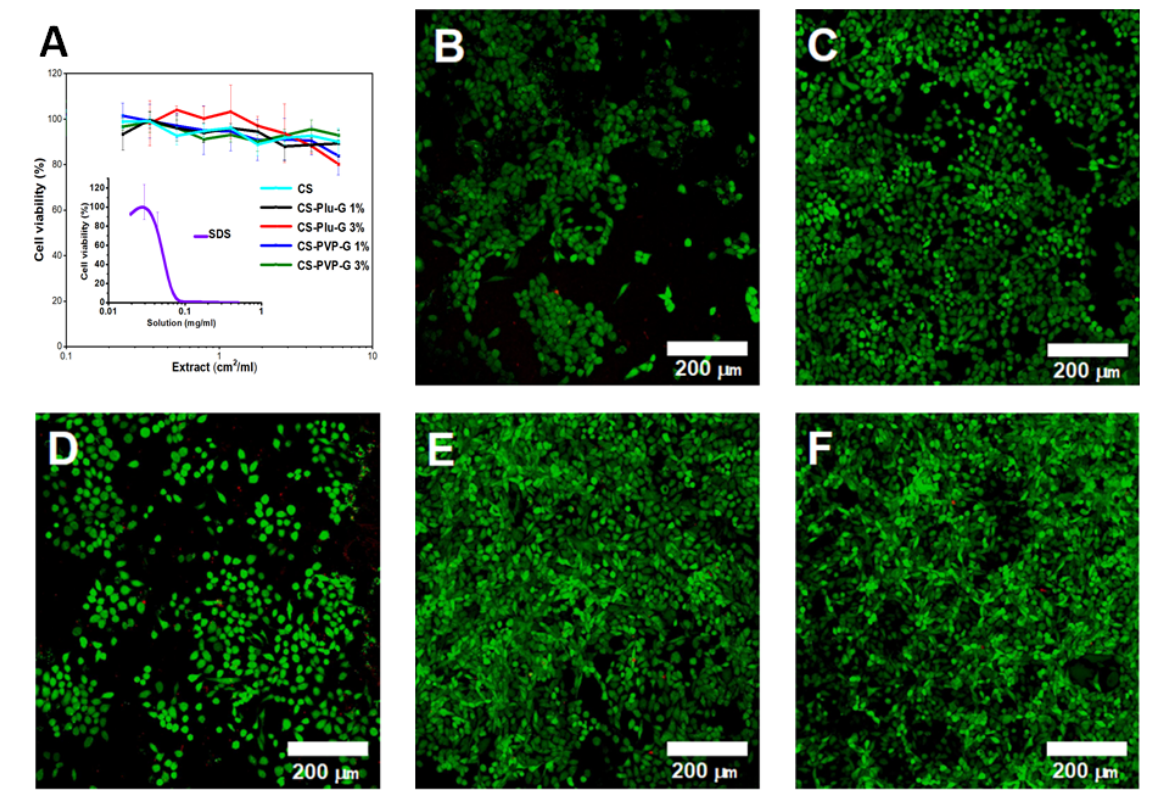
Figure 6. ( A ) Cytotoxicity of composite films established by MTT-test with SDS. The graphs show that films do not release cytotoxic components into cell culture medium in comparison with SDS. Confocal laser scanning microscopy of 3T3 murine fibroblasts stained with calcein-AM (green) and ethidium homodimer-1 (red) after 72 h of culturing on the sample surfaces and a glass coverslip (control): ( B ) CS, ( C ) CS-Plu-G 1%, ( D ) CS-Plu-G 3%, ( E ) CS-PVP-G 1%, ( F ) CS-PVP-G 3%. Life–dead method has shown that films are amiable for cell culturing. The scale bar represents 200 μm.